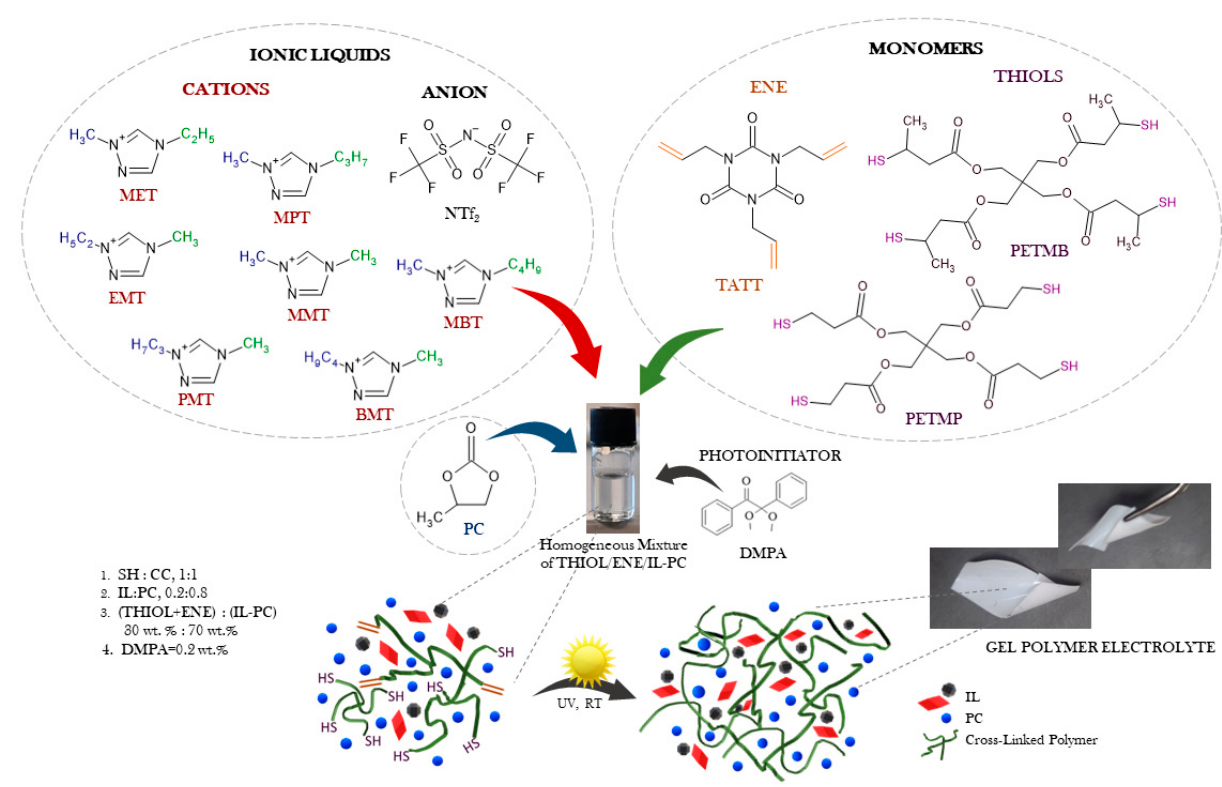
Figure 2. Schematic illustration of GPEs synthesis.